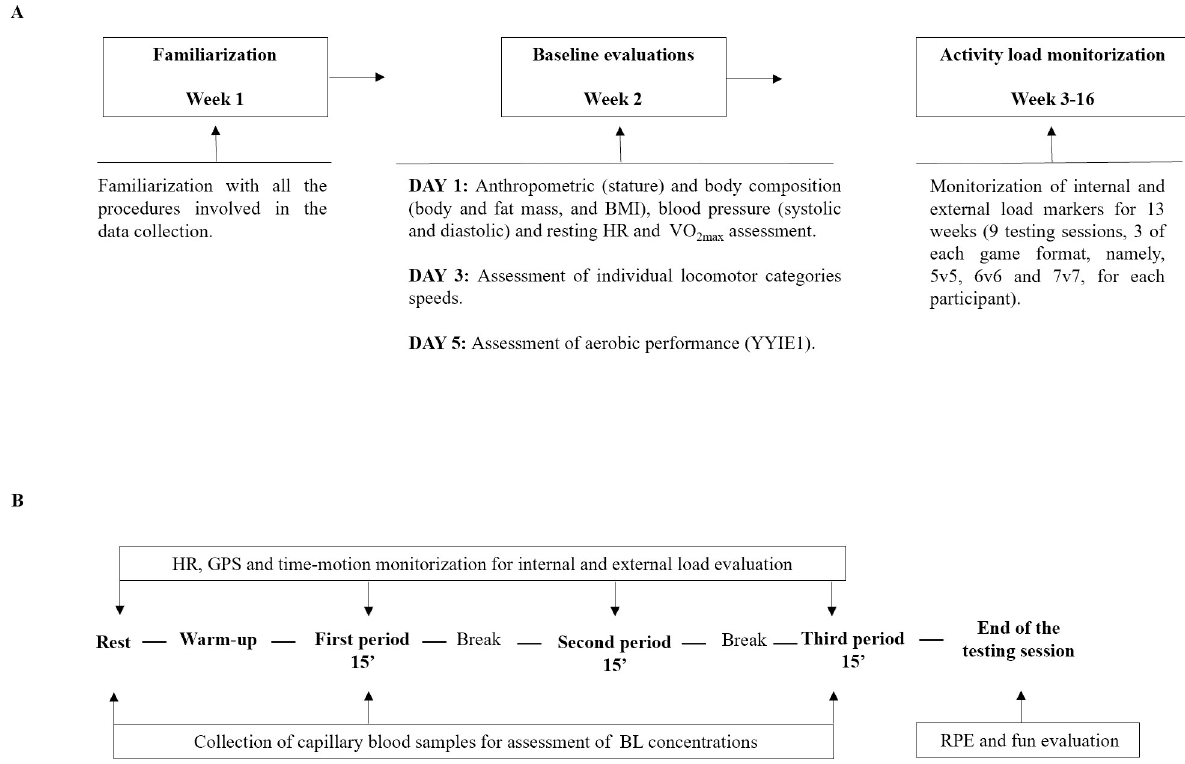
Fig 1. Schematic representation of the study protocol. BMI–Body mass index; HR–Heart rate; VO 2max − Maximal oxygen uptake; YYIE1—Yo-Yo intermittent endurance level 1 test; GPS—Global positioning system; BL–Blood lactate; RPE—Rating of perceived exertion.